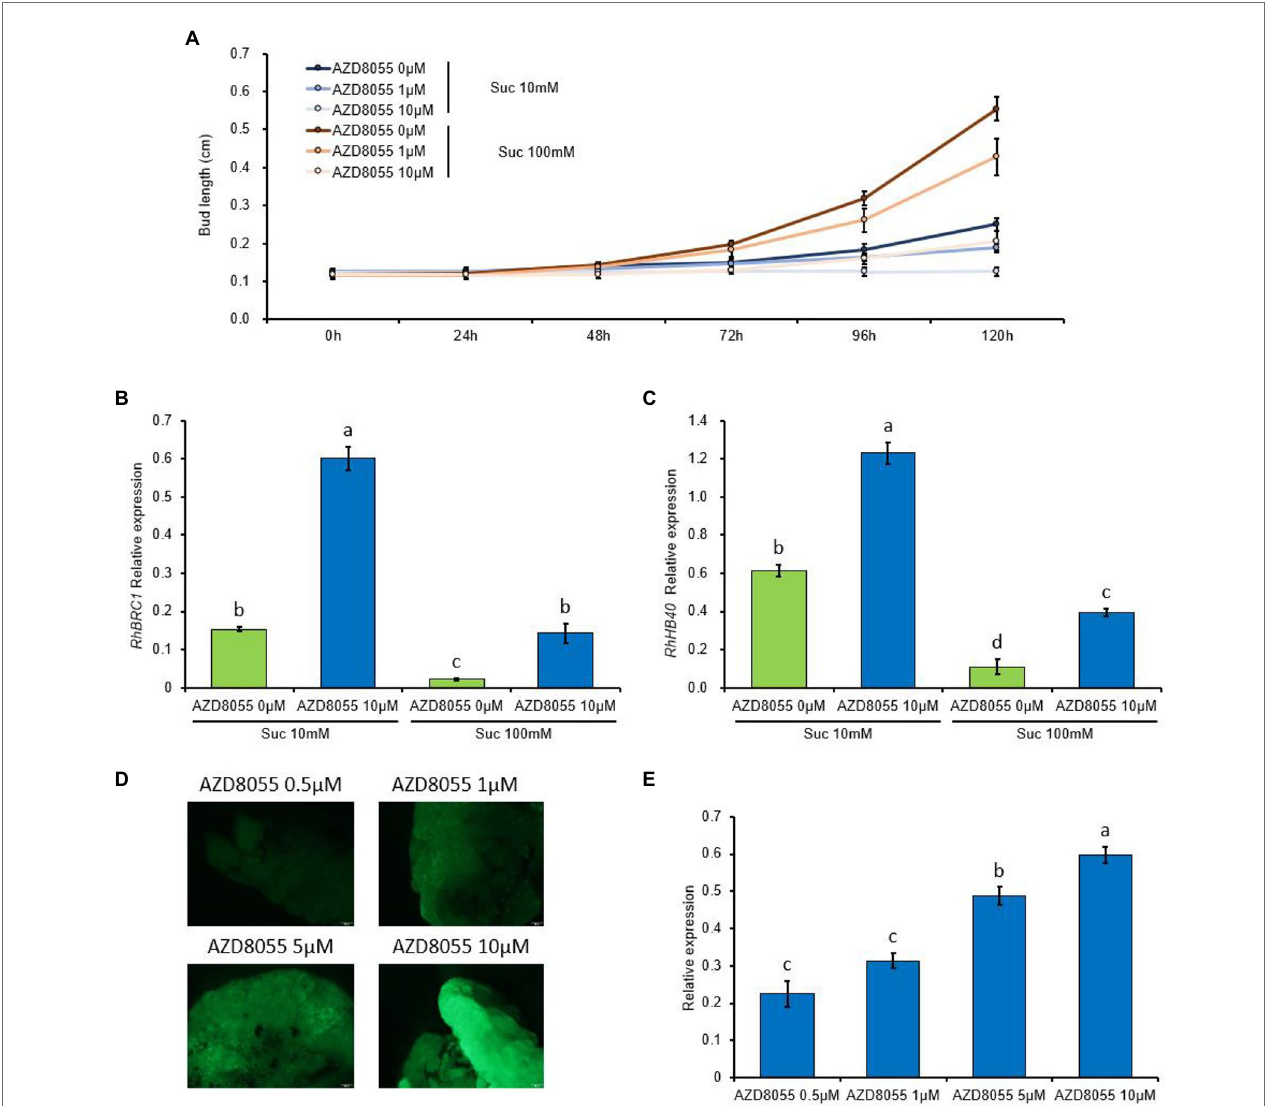
FIGURE 9 | TOR kinase regulates bud outgrowth and RhBRC1 expression through its promoter region. (A) Lengths of buds treated with different sucrose concentrations and AZD8055 (50 buds per treatment); (B,C) transcription levels of RhBRC1 and RhHB40 , respectively; (D) fluorescence levels of the 1973 bp- RhBRC1 promoter in stably transformed calluses placed on different concentrations of AZD8055; and (E) transcription levels of GFP in the calluses treated with different concentrations of AZD8055. Green bars, sucrose treatment alone; blue bars, combined supplementation of sucrose and AZD8055. Data are the means of three biological replicates ± standard error (SE). Letters, significant differences between the different treatments with p <